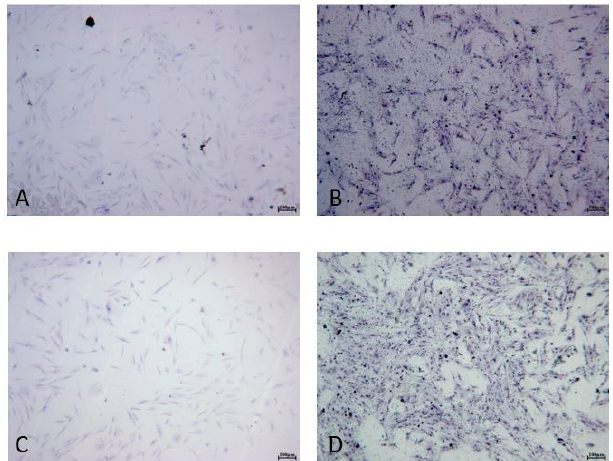
Figure 2. Cell morphology. HGF were subjected to ALAD-PDT protocol and stained after 24 h with toluidine blue. ( A ) CTRL, ( B ) 0-ALAD-PDT, ( C ) 100-ALAD, ( D ) 100-ALAD-PDT .